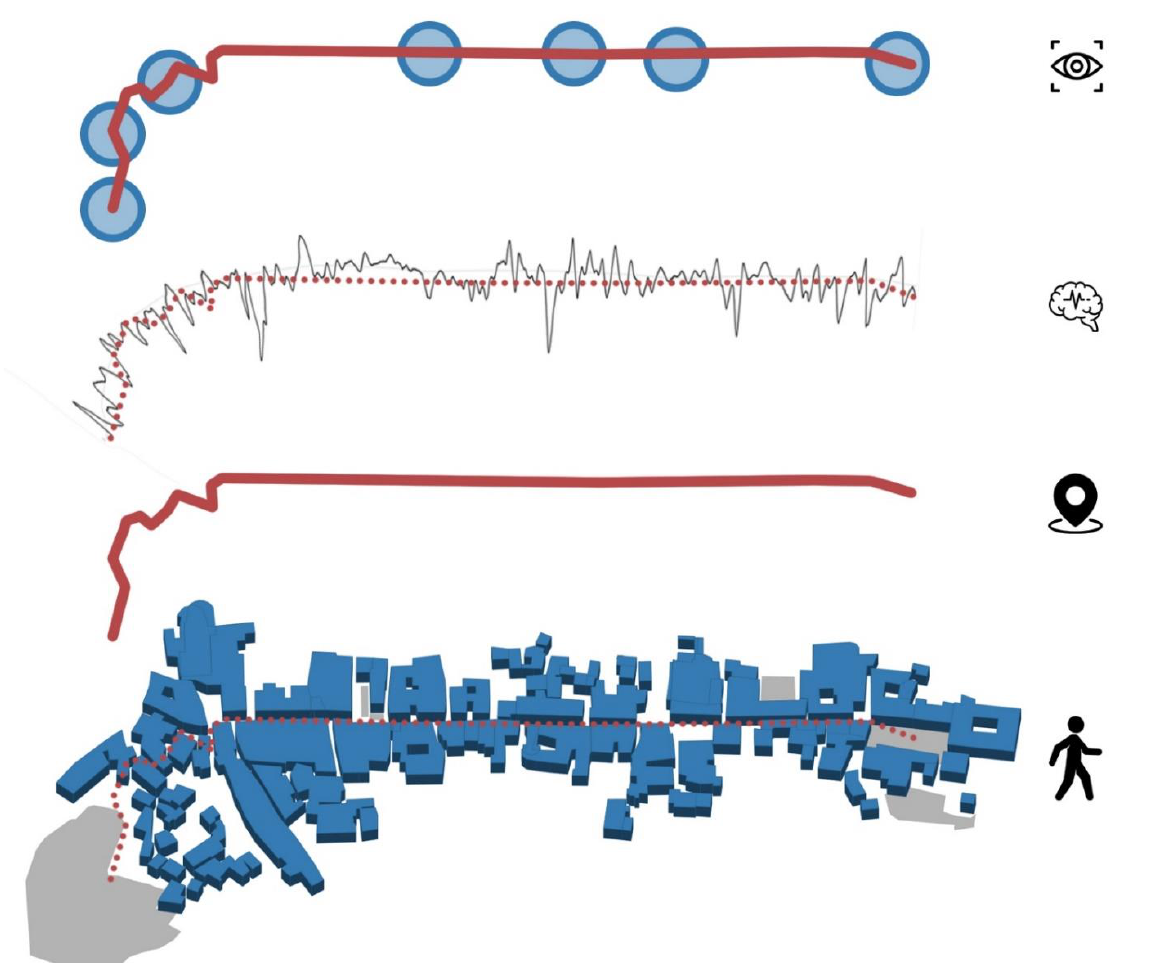
Figure 1. Methodology used: route taken on foot during data acquisition, spatial data acquisition (GNSS), EEG data acquisition, eye-tracker data